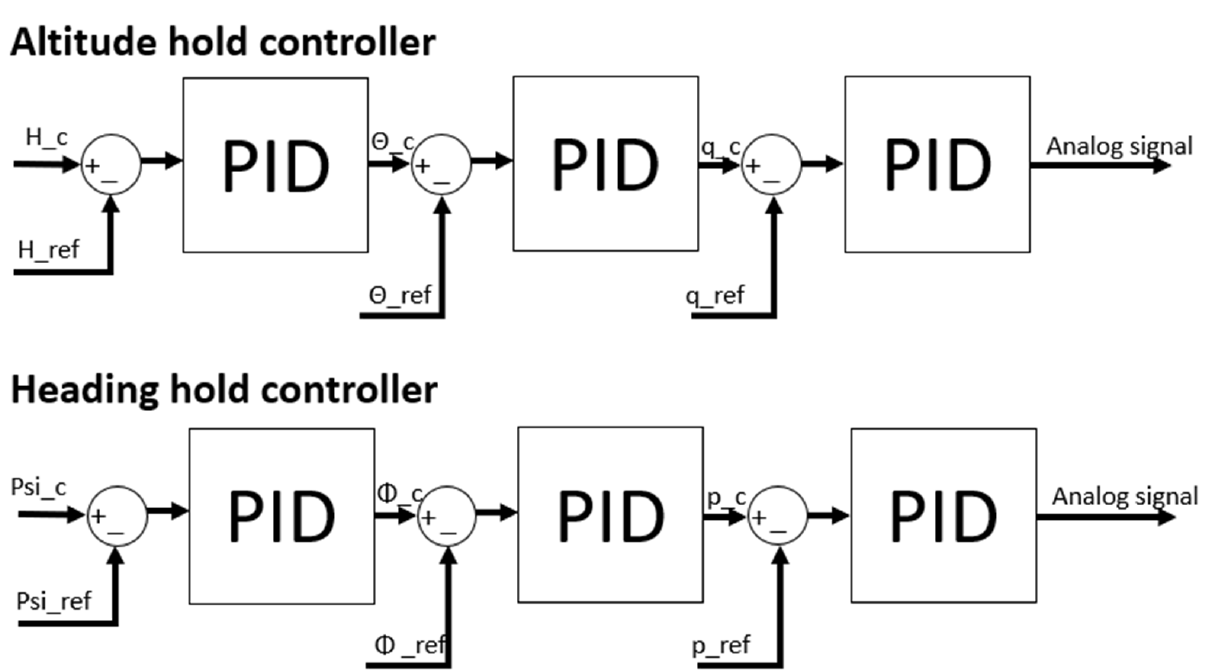
Figure 2. Simplified scheme of the STAB mode algorithm.